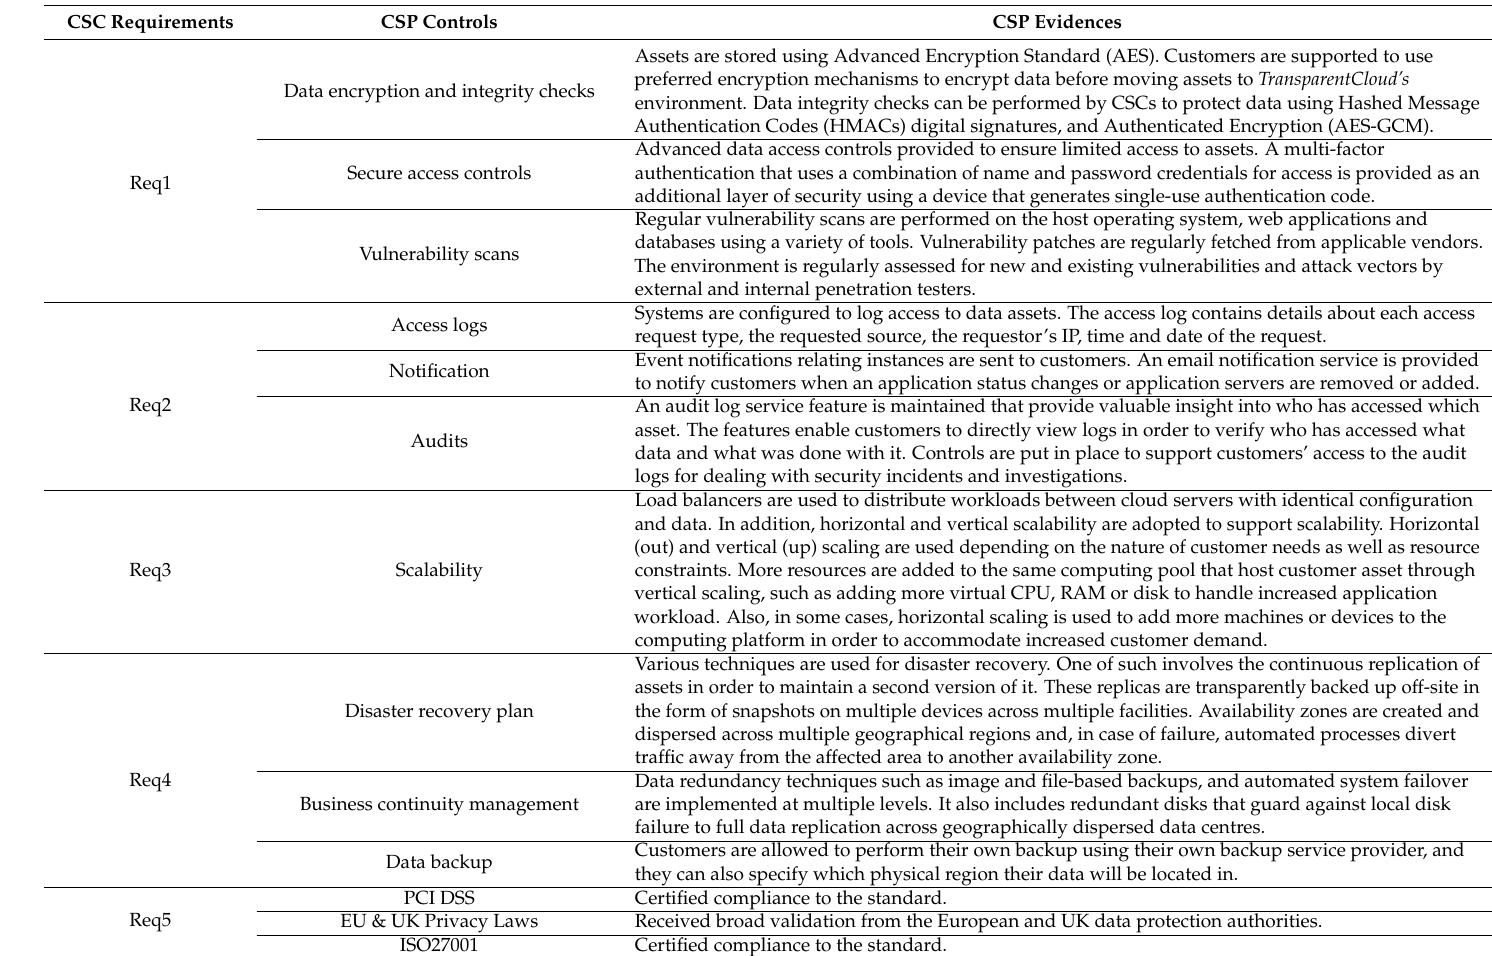
Table 3. Evidences of TransparentCloud’s security